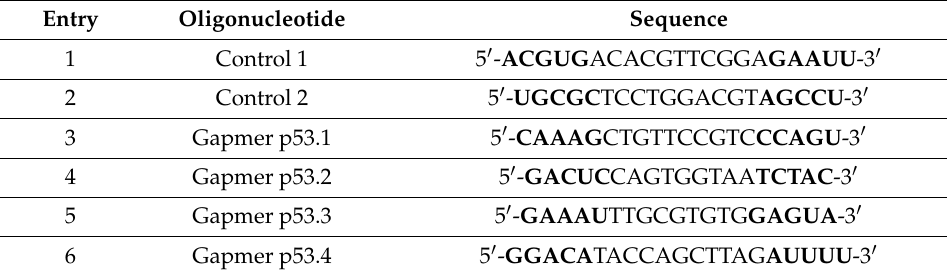
Table 2. Oligonucleotides used in this